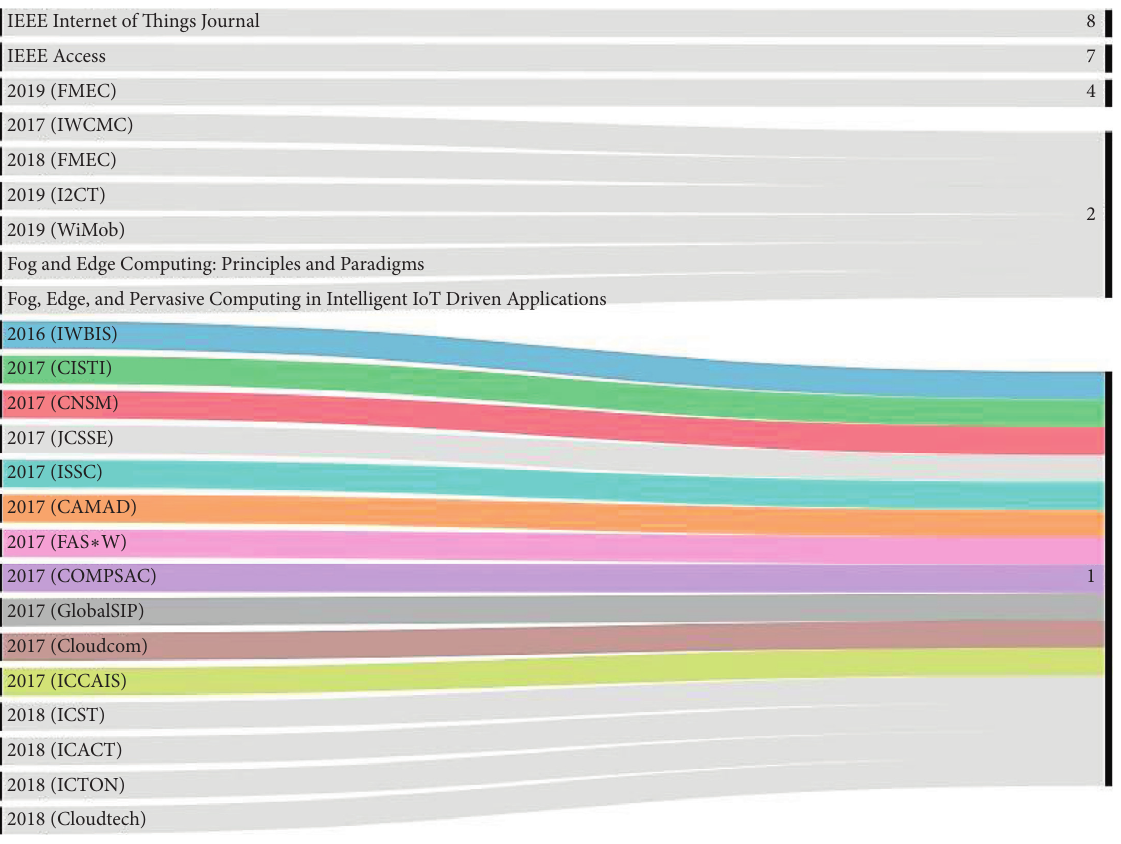
Figure 8: Publication titles and papers.